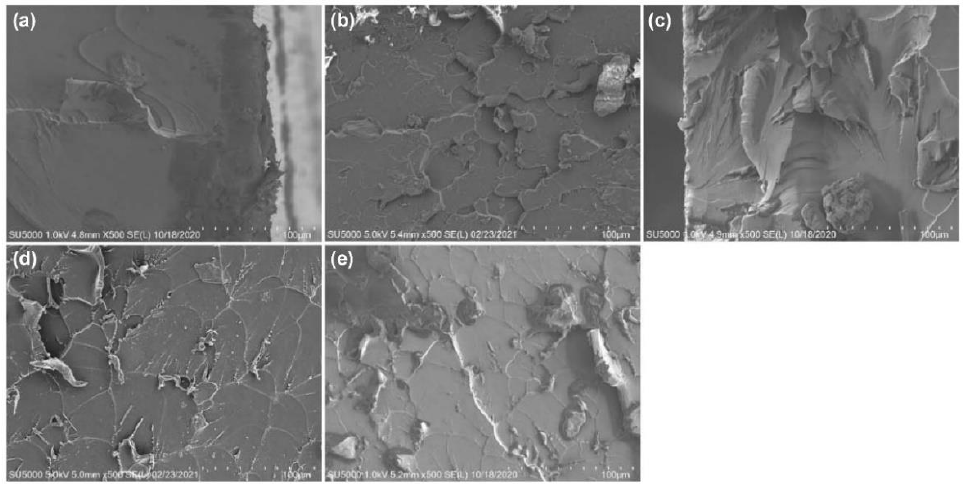
Figure 8. SEM images of ( a ) pure epoxy resin, ( b ) 0.5 wt.%, ( c ) 1.0 wt.%, ( d ) 3.0 wt.%, and ( e ) 5.0 wt.% TiO 2 –epoxy nanocomposites with focused